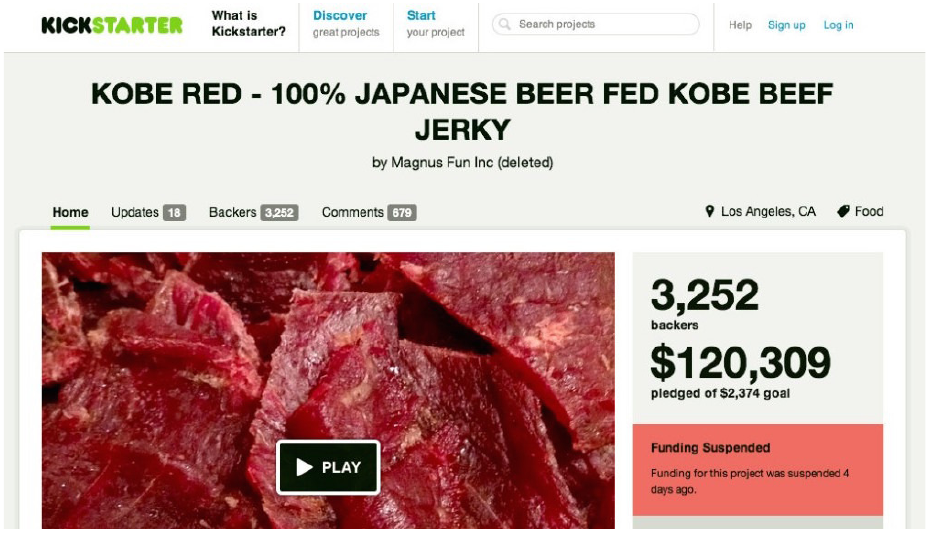
Figure 1. A well-known crowdfunding